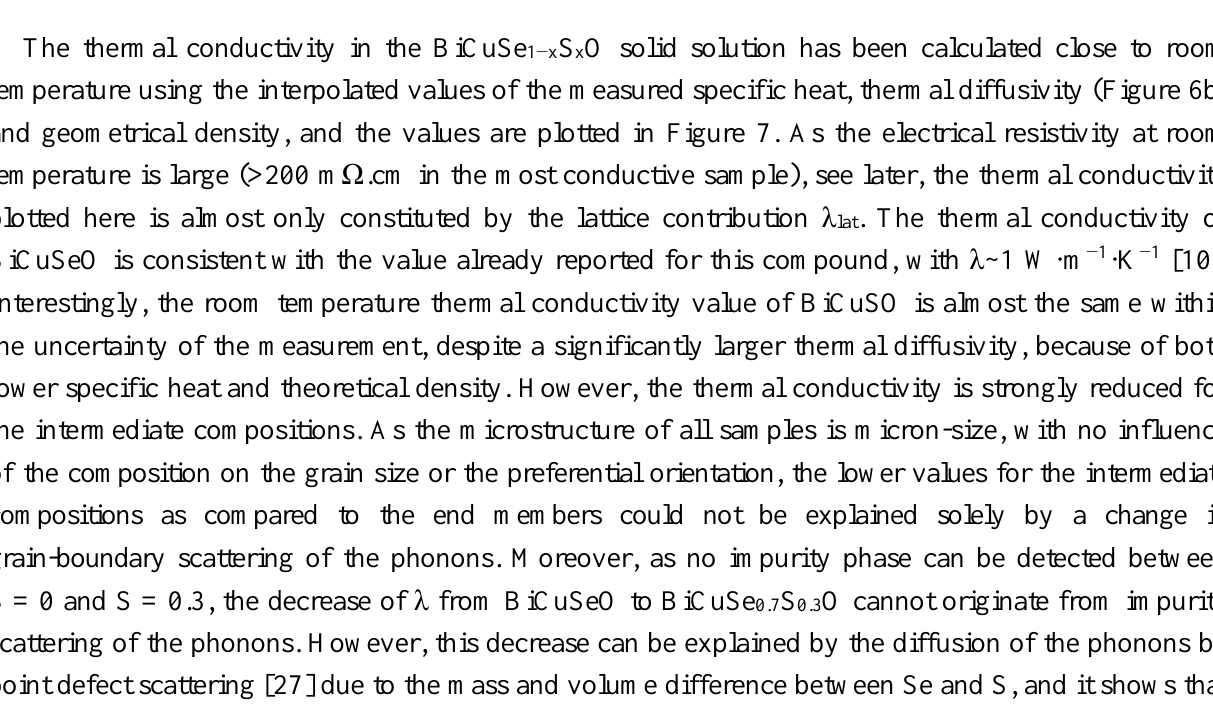
Figure 6. Temperature dependence of the specific heat ( a ), for the clarity of the figure, only 3 curves were plotted, and temperature dependence of the thermal diffusivity of BiCuSe 1−x S x O pellets ( b